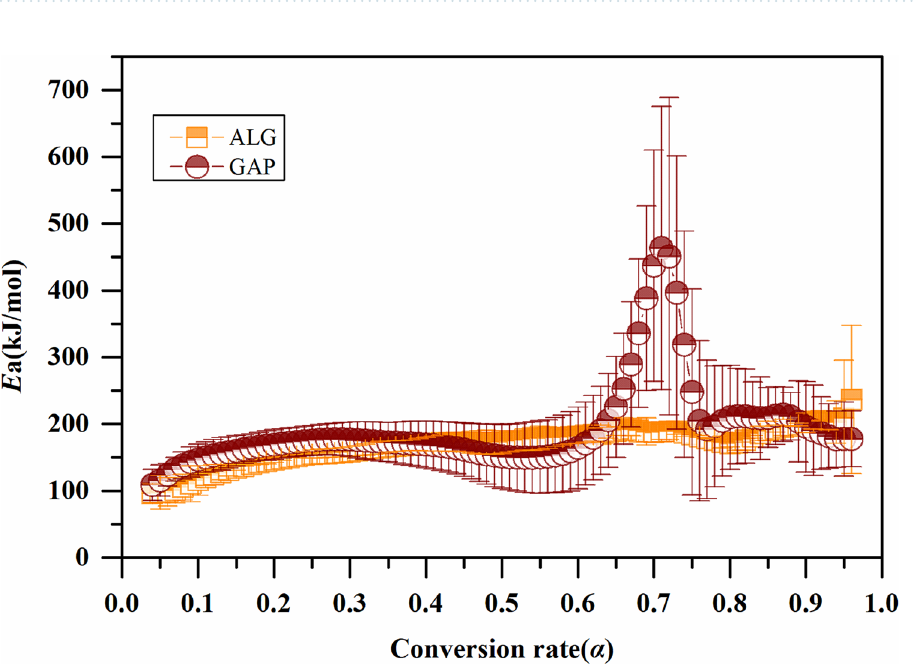
Figure 3. Activation energy profiles of ALG and GAP over conversion